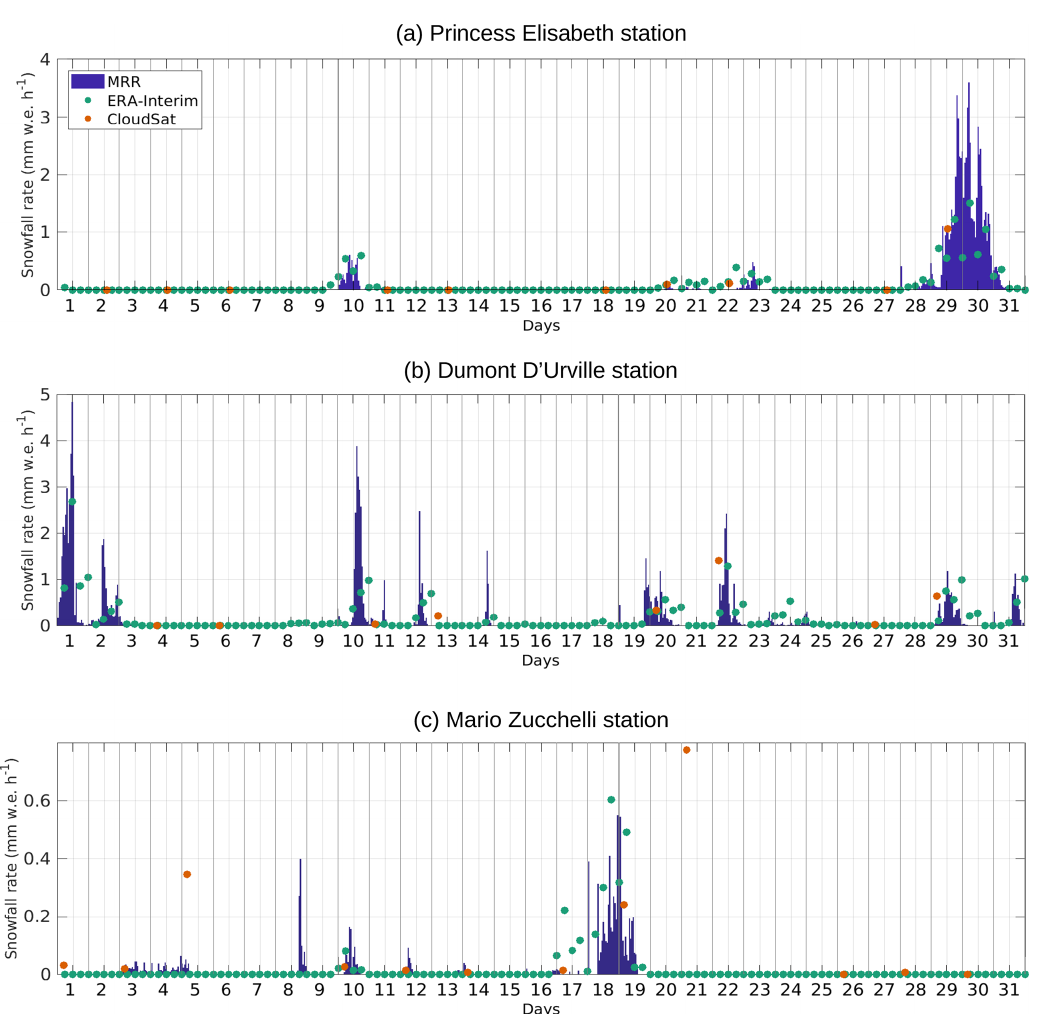
Figure 3. Snowfall rates (mmw.e.h − 1 ) during March 2016 at the three stations derived from the MRRs (blue bars), the grid box comprising each of the three stations in ERA-Interim reanalysis (green) and the average of the CloudSat overpasses in the grid box (1 ◦ latitude by 2 ◦ longitude) comprising each of the three stations following the approach of Palerme et al. (2014) (red). Notice the difference in vertical scale for each of the